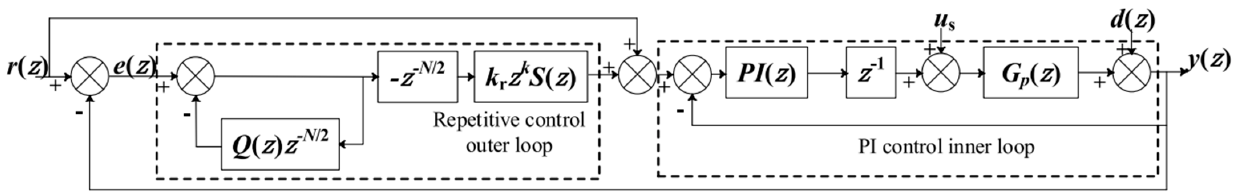
Figure 14. Bode diagram of a half-cycle SDFT.